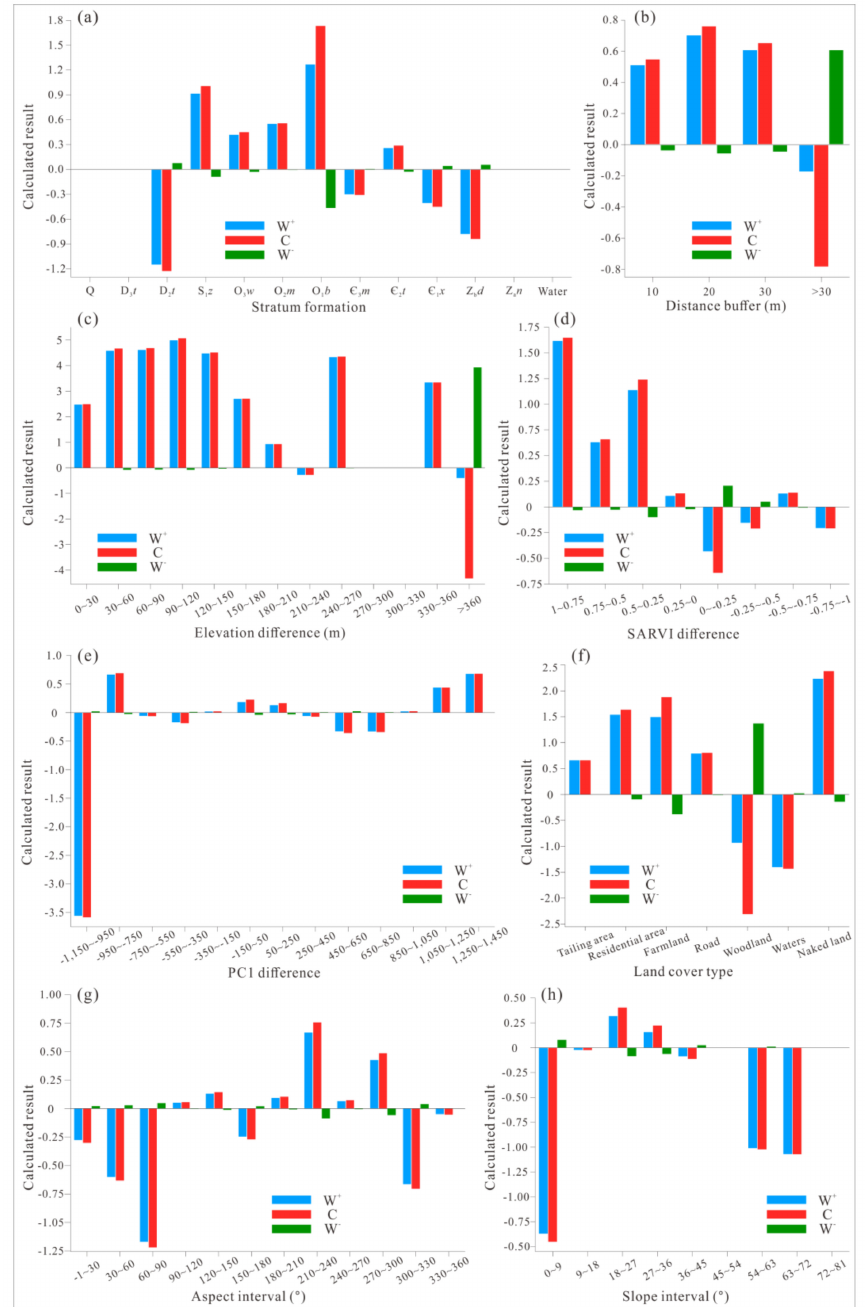
Figure 15. Calculated results of WofE, showing the different predictive factors: ( a ) lithology of the strata, ( b ) distance buffers of the faults, ( c ) elevation difference between the underground excavations and the surface, ( d ) SARVI difference, ( e ) PC-1 difference, ( f ) land cover, ( g ) aspect, and ( h )